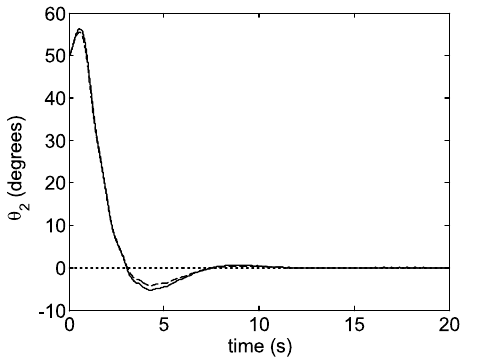
Fig. 5. Estimated (- - -) and “real” (—) behavior of measured vari- able θ 2 considering same initial conditions.